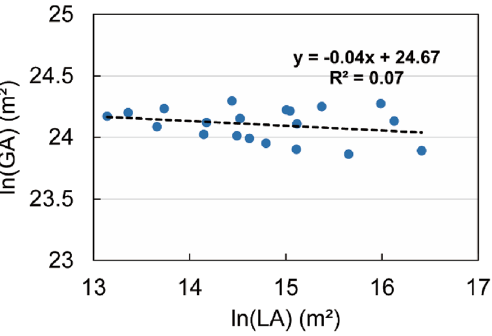
Figure 9. Graph of landslide area and glacier area. GA represents glacier area, and LA represents landslide area, and ln represents the natural log. The black dotted line is the linear trend